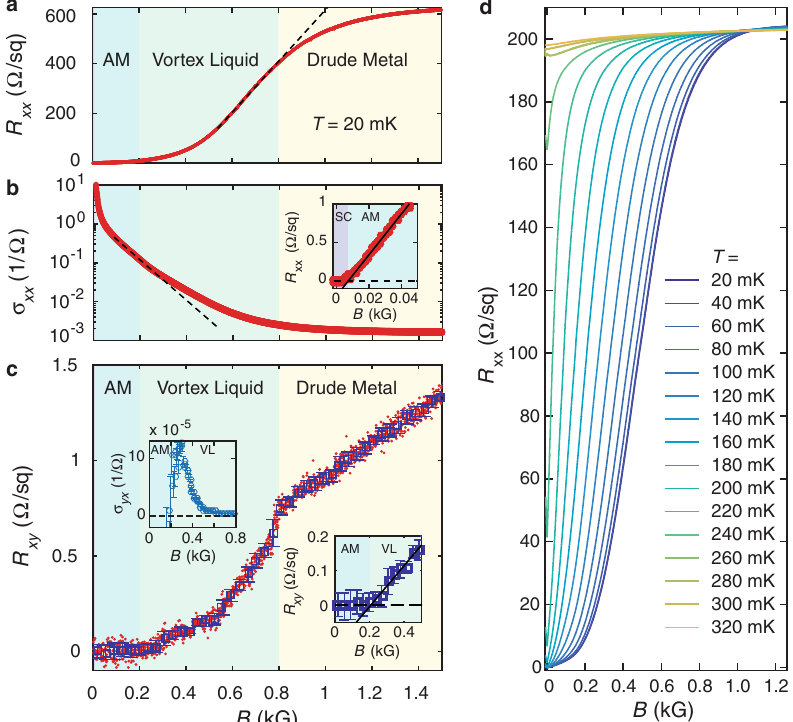
Fig. 3 Magnetic fi eld tuned superconductor-metal transition. a , b Resistivity-versus-magnetic fi eld ( R – B ) and conductivity-versus-magnetic = 1.8 V in sample B, respectively. The dashed lines are an exponential fi t for low fi eld data and a fi eld curves measured at T = 20 mK and V G linear fi t for the intermediate fi eld data in a , b , respectively. The inset of b is a magni fi cation of the low fi eld data in linear scale to show the small superconducting regime. SC: superconductor. AM: anomalous metal. c Hall resistivity as a function of magnetic fi eld at T = 20 mK and V G = 1.8 V in sample B. Red dots are raw data. Blue squares are moving averages of the raw data. The lower inset is a magni fi cation of the low fi eld data to show the onset of non-zero Hall resistivity. The upper inset shows the transverse conductivity σ yx as a function of the magnetic fi eld. VL: vortex liquid. Error bars represent standard deviations. d R – B curves at different temperatures of sample A.